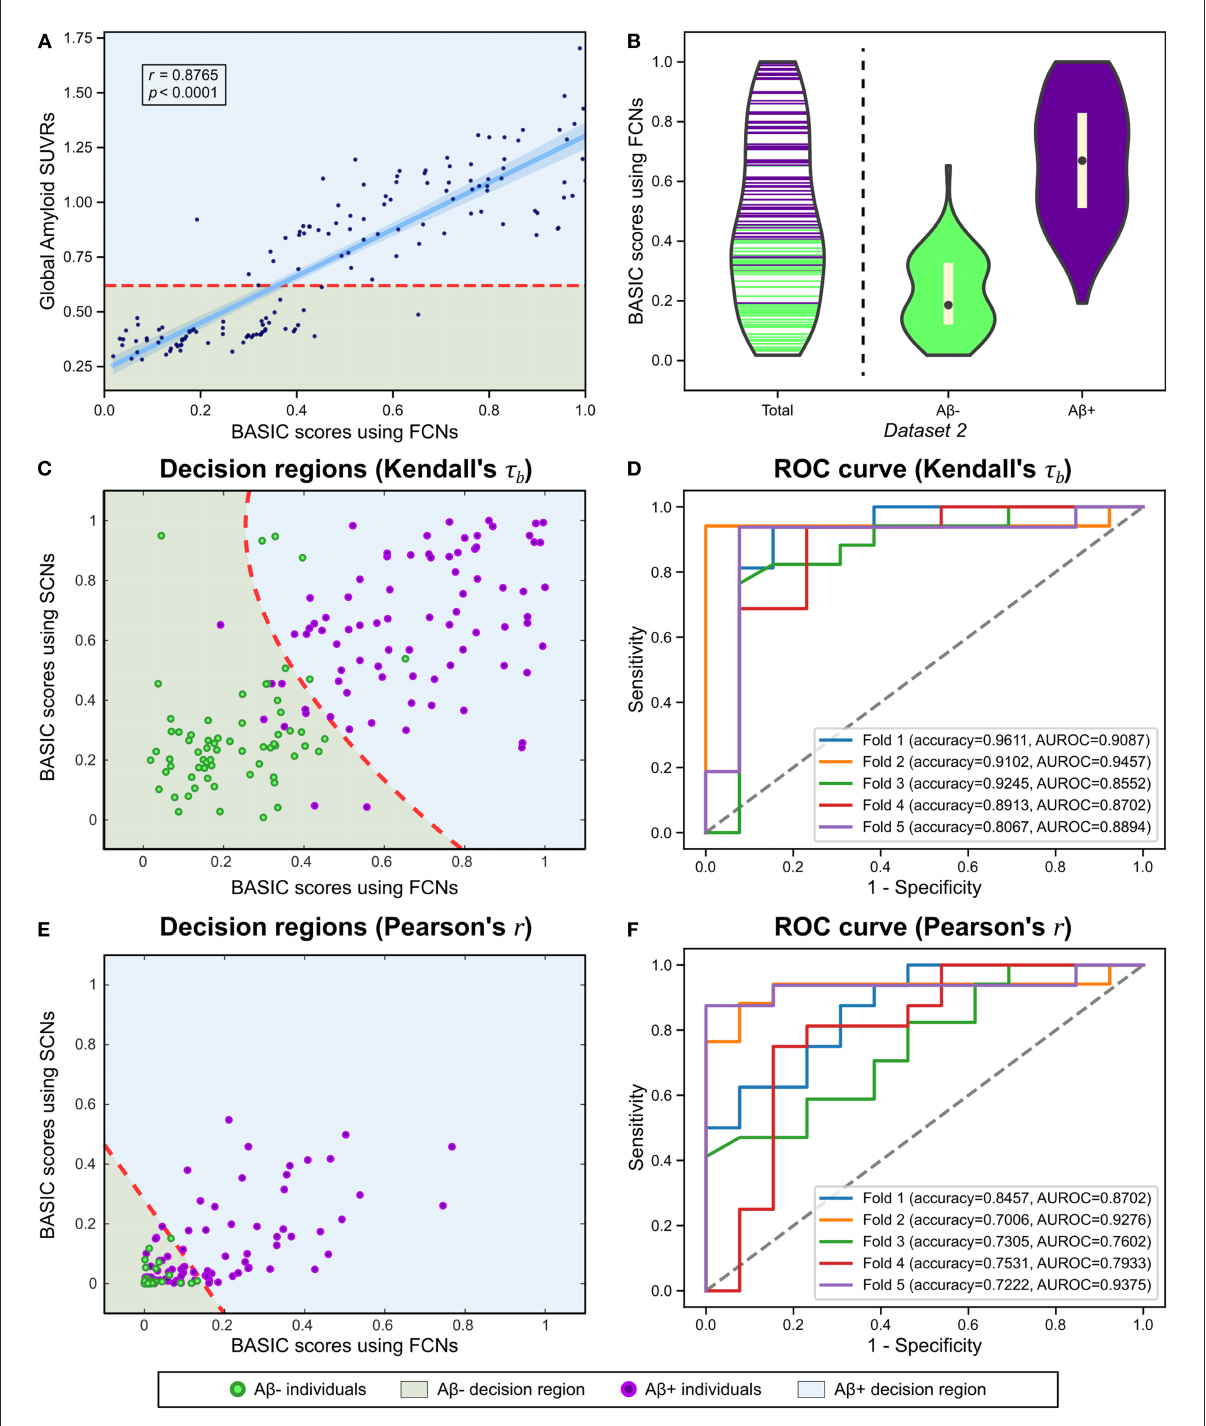
FIGURE7 Using functional connectivity networks (FCNs), the BASIC scores were determined in a manner that maximizes Kendall’s rank correlation coefficient ( τ b ) with the global amyloid standard uptake value ratio (SUVR) measured on a continuous scale. (A) Regression plot for the BASIC scores and the global amyloid SUVR. (B) Violin plots depicting the estimated distributions of the BASIC scores of individuals in Dataset 2 according to amyloid status ( i.e. , amyloid positive or negative). (C) Decision regions and boundary derived from the classification analysis using the BASIC scores using FCN and structural connectivity networks (SCNs), determined in an manner that maximizes Kendall’s τ b . (D) The corresponding receiver operating characteristic (ROC) curves for five-fold cross-validation (CV). (E) Decision regions and boundary derived from the classification analysis using BASIC scores using FCNs and SCNs, determined in a manner that maximizes the Pearson’s product-moment correlation coefficient (Pearson’s r ). (F) The corresponding ROC curves for five-fold